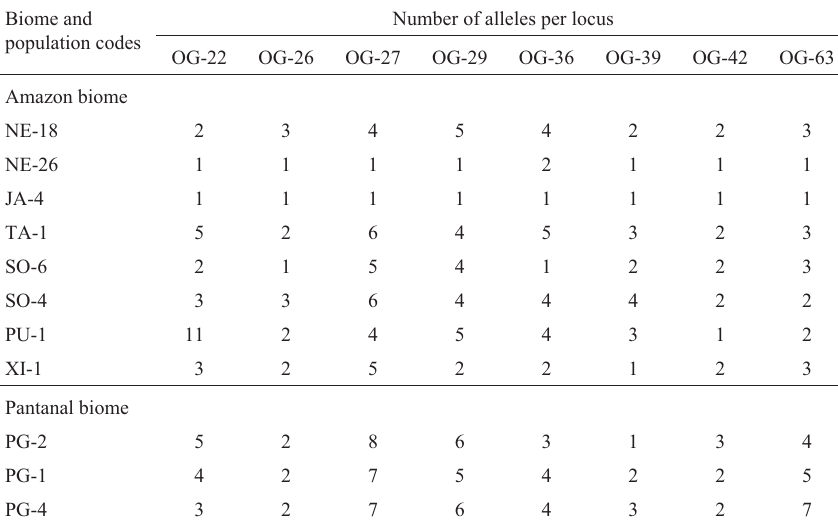
Table 3 - Number of alleles per locus for eleven Brazilian Oryza glumaepatula populations .